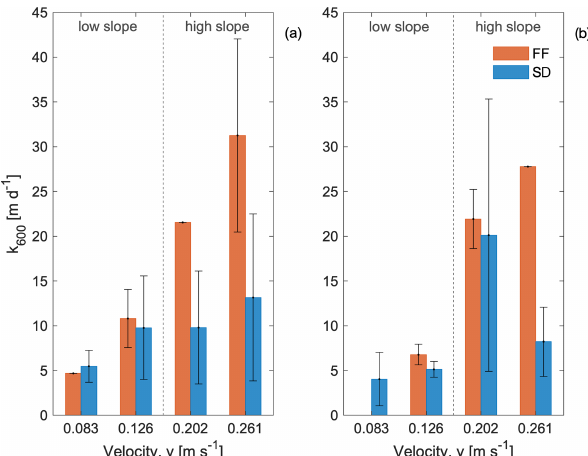
Figure 2. Bar plot of the k 600 values as a function of channel slope and flow velocity for steady (a) and drifting (b) modes. Error bars (standard deviations) are inserted to visualize the variability among replicate